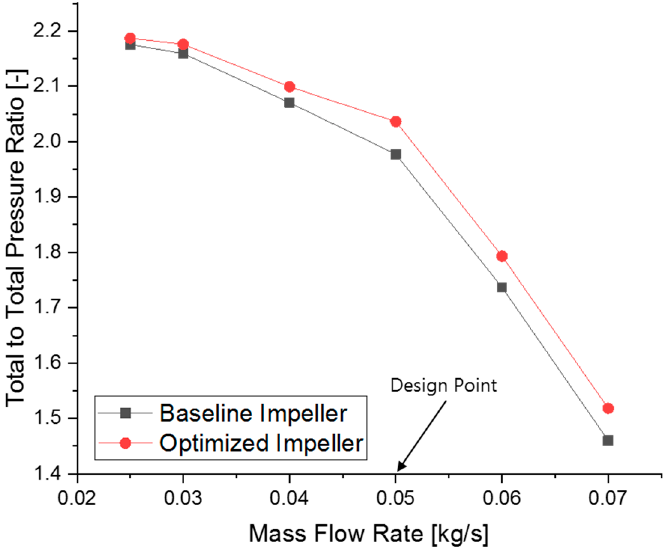
Figure 13. Total-to-total pressure comparison between the optimal and baseline impellers.